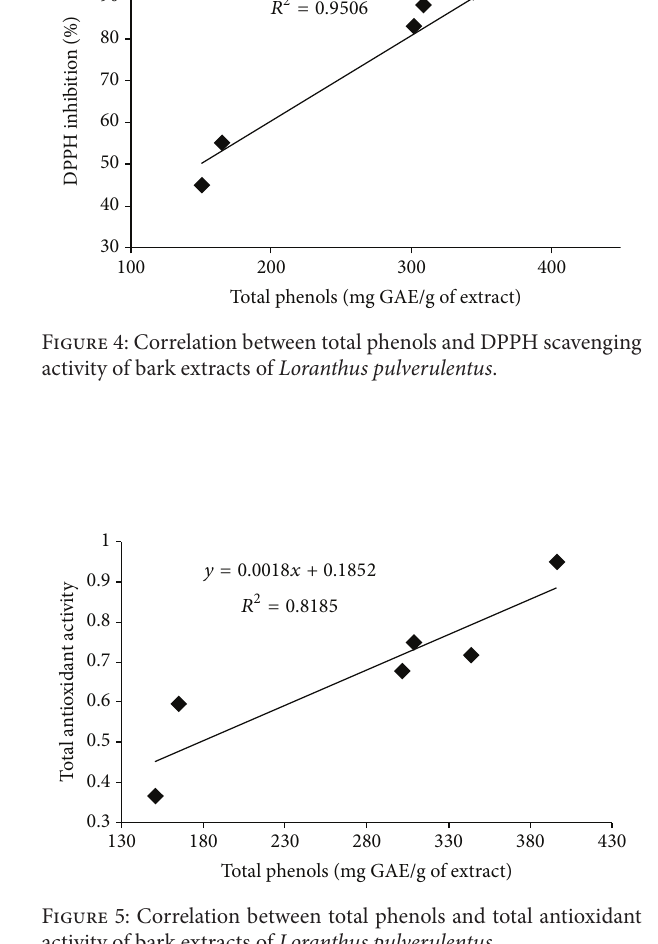
Figure 5: Correlation between total phenols and total antioxidant activity of bark extracts of Loranthus pulverulentus